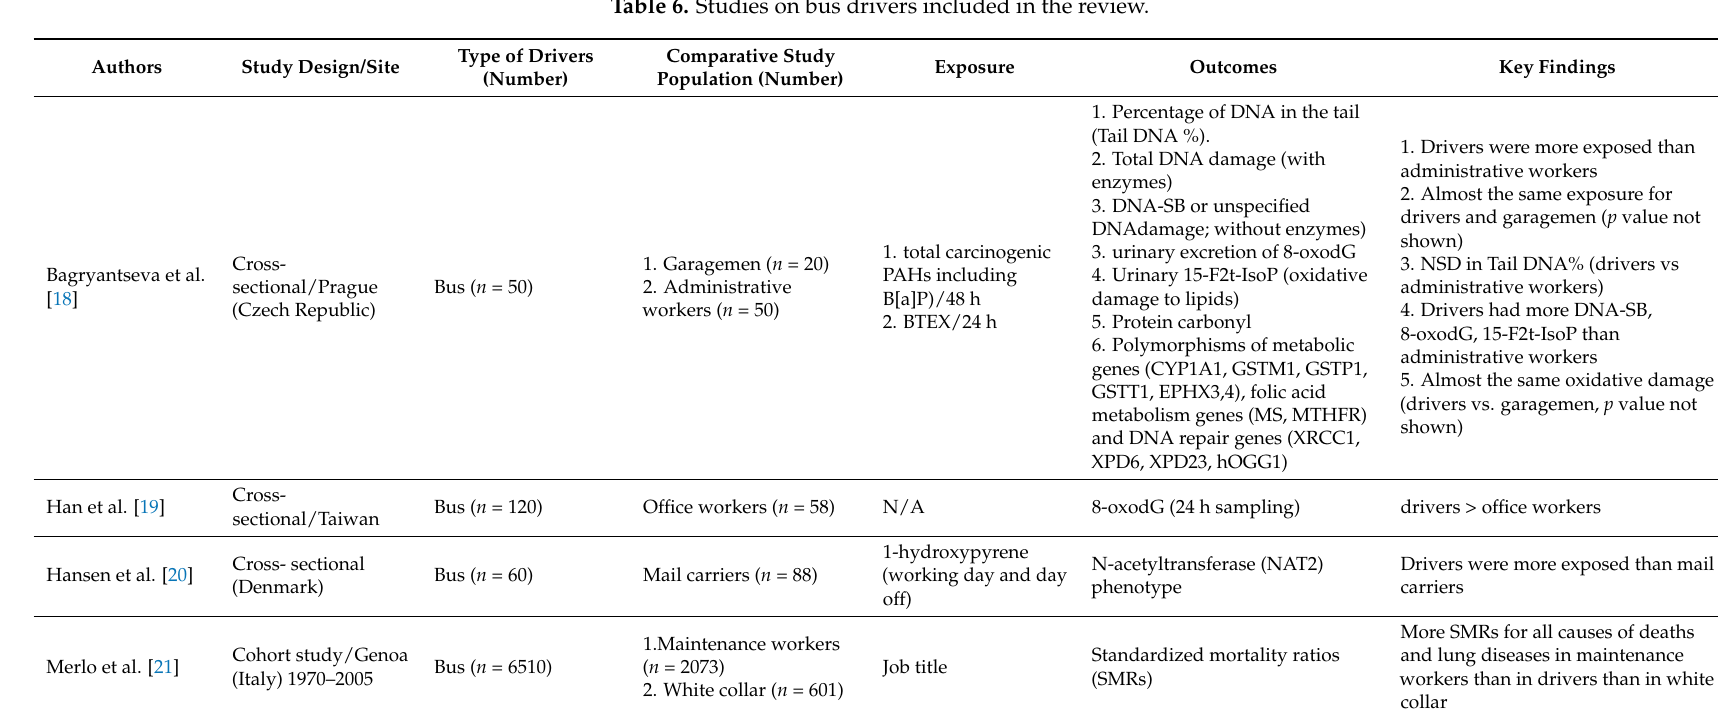
Table 6. Studies on bus drivers included in the